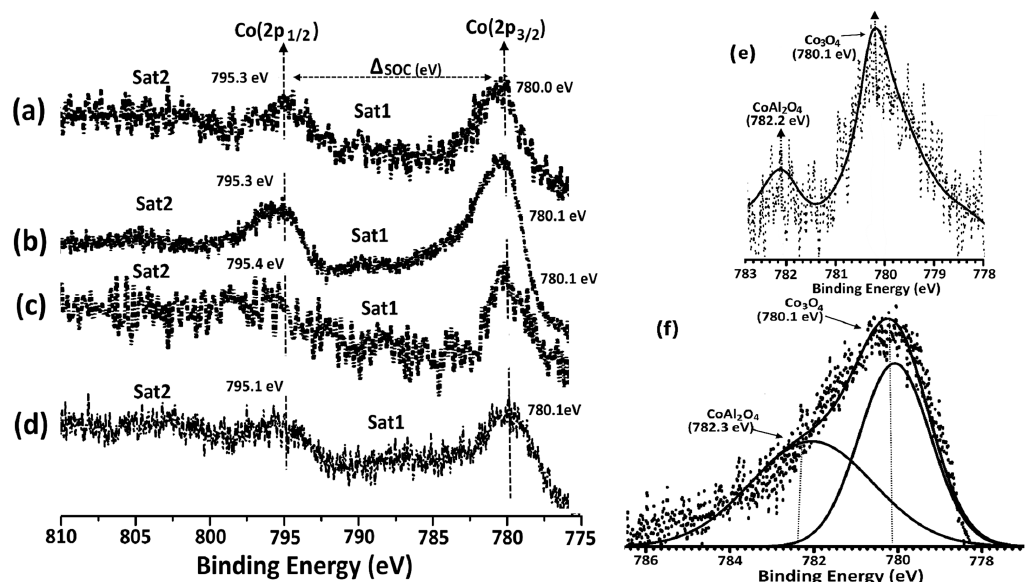
Figure 8. High resolution XPS spectra of the Co2p of the calcined Co / NS ( a ), Co / Al 2 O 3 ( b ), Co / NS-Al-A ( c ) and Co / NS-Al-B ( d ) catalysts, and expanded region showing CoAl 2 O 4 for the calcined ( e ) Co / NS-Al-A and ( f ) Co / NS-Al-B